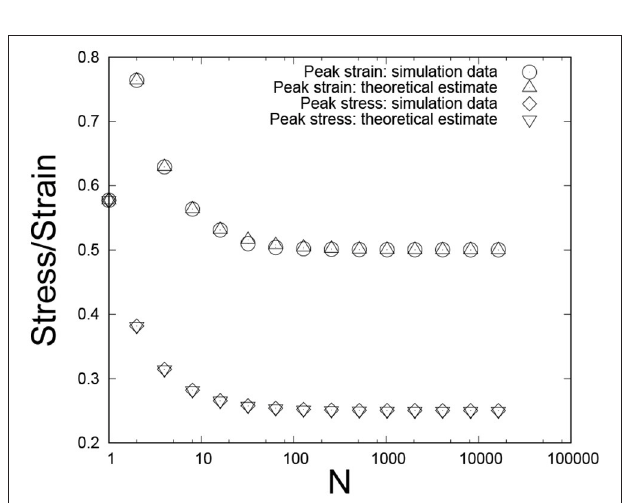
FIGURE 5 | 1 c N and the corresponding force F c N / N as we iterate the order-space renormalization group. The initial number of fibers was N and the uniform distribution on the unit interval was assumed. Averages were taken over 10 6 samples.